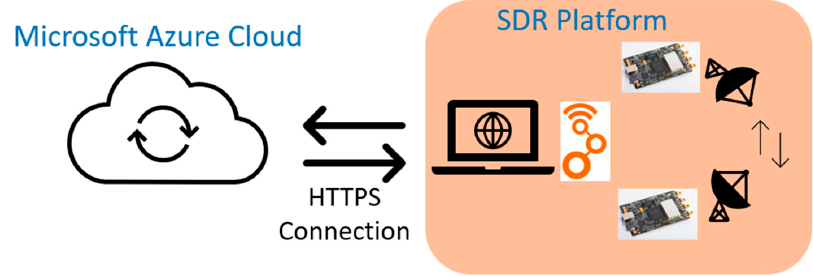
Figure 1. Component